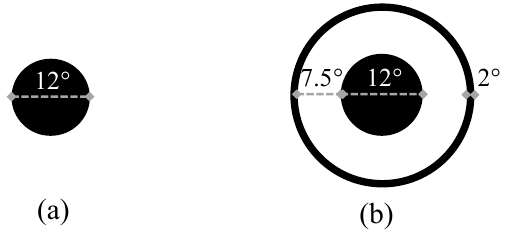
Figure 1. ( a ) Specifications of the central scotoma (CS) and ( b ) augmented scotoma (AS) condition. In the CS condition the scotoma ( a ) had a diameter of 12°. In the AS condition ( b ) there was an concentric augmentation of 2° around the scotoma and an annulus area extending